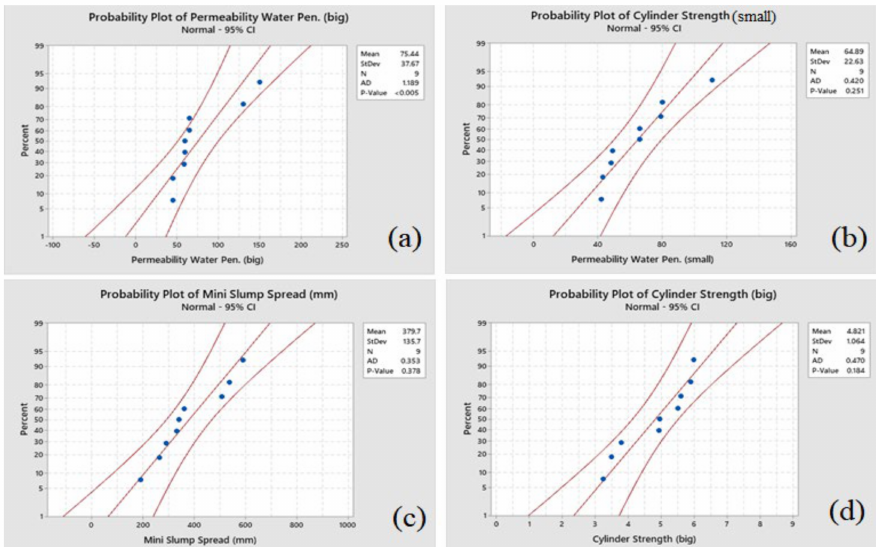
Figure 16. Normal probability plot for ( a ) permeability water penetration depth for coarse aggregates sample, ( b ) mass-cylinder strength with fine aggregates, ( c ) mini slump spread (mm), and ( d ) mass- cylinder strength with coarse